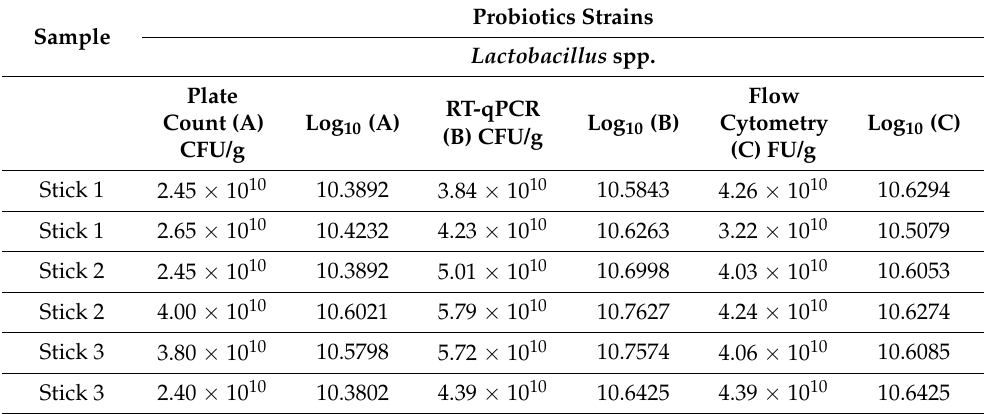
Table 10. Measurements expressed as Log10 for Lactobacillus spp. (Table 10) in food supplement 2, obtained by the three methods tested.